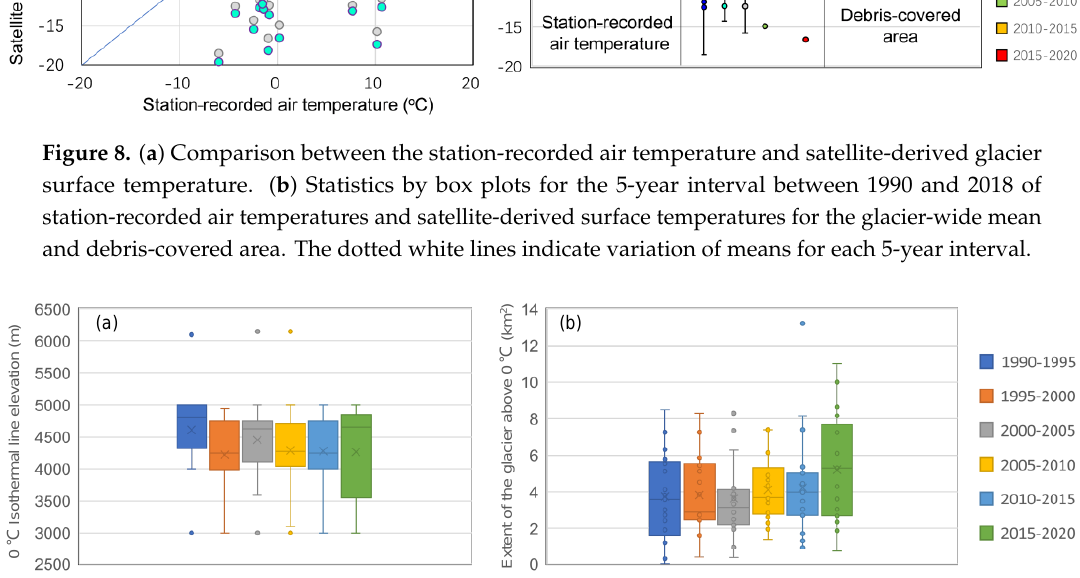
Figure 9. Statistics by box plots for the 5-year interval between 1990 and 2018 of the 0 °C isothermal line elevation ( a ) and extent of the glacier surface above 0 °C ( b ) .